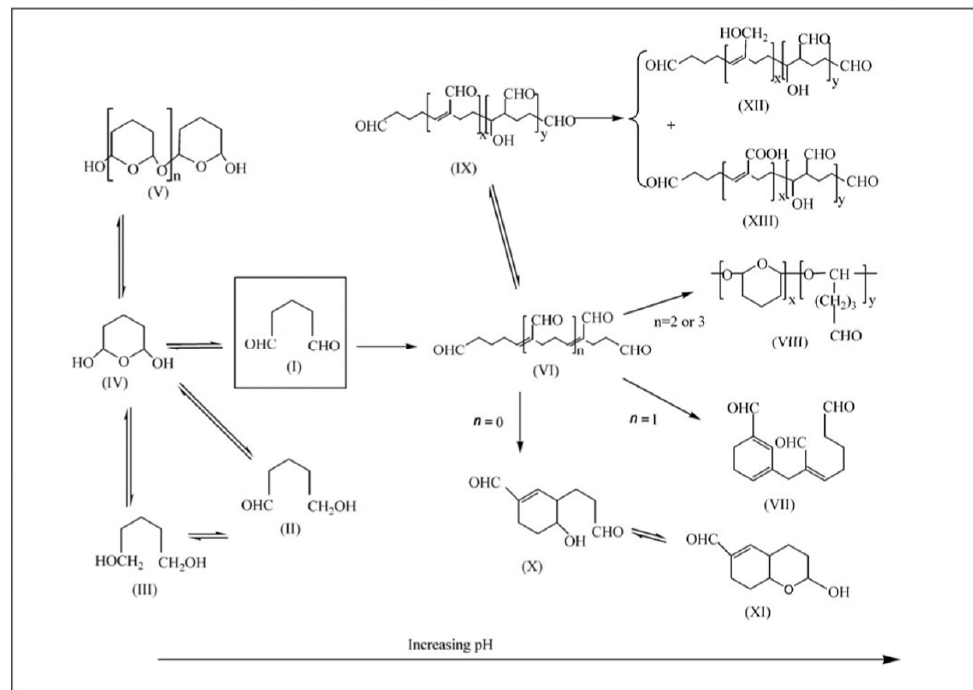
Figure 11. Summary of the possible forms of glutaraldehyde in aqueous solution [125]. Reproduced by permission from Biotechniques as agreed by Future Science Ltd. (London, UK).